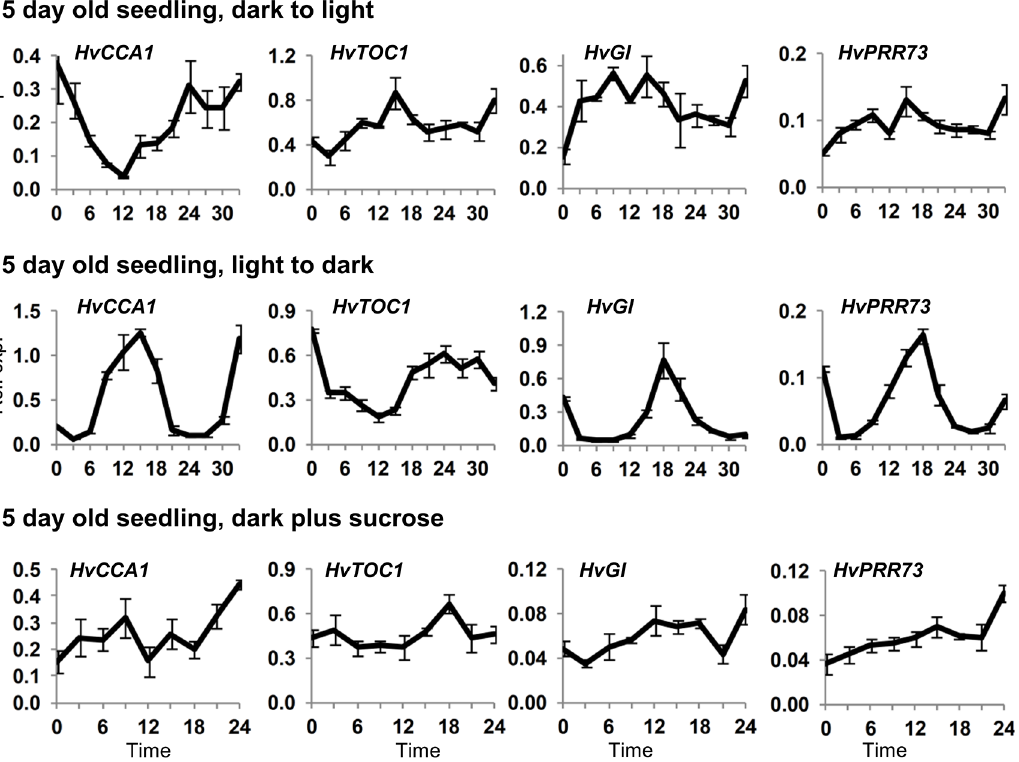
Fig 2. Clock gene expression after light/dark transitions or with exogenous sucrose. Gene expression, assayed by qRT-PCR, in 5 day old barley seedlings (cv. Sonja) germinated and grown in: (A) constant darkness then shifted to light, (B) constant light then shifted to darkness or (C) constant darkness plus 2% sucrose. RNA was extracted from 3 biological repeats. Average expression is shown relative to ACTIN (Rel. exp.), error bars show standard error. Horizontal axis labels indicate the time (hours) relative to when the first sample was harvested and treatments